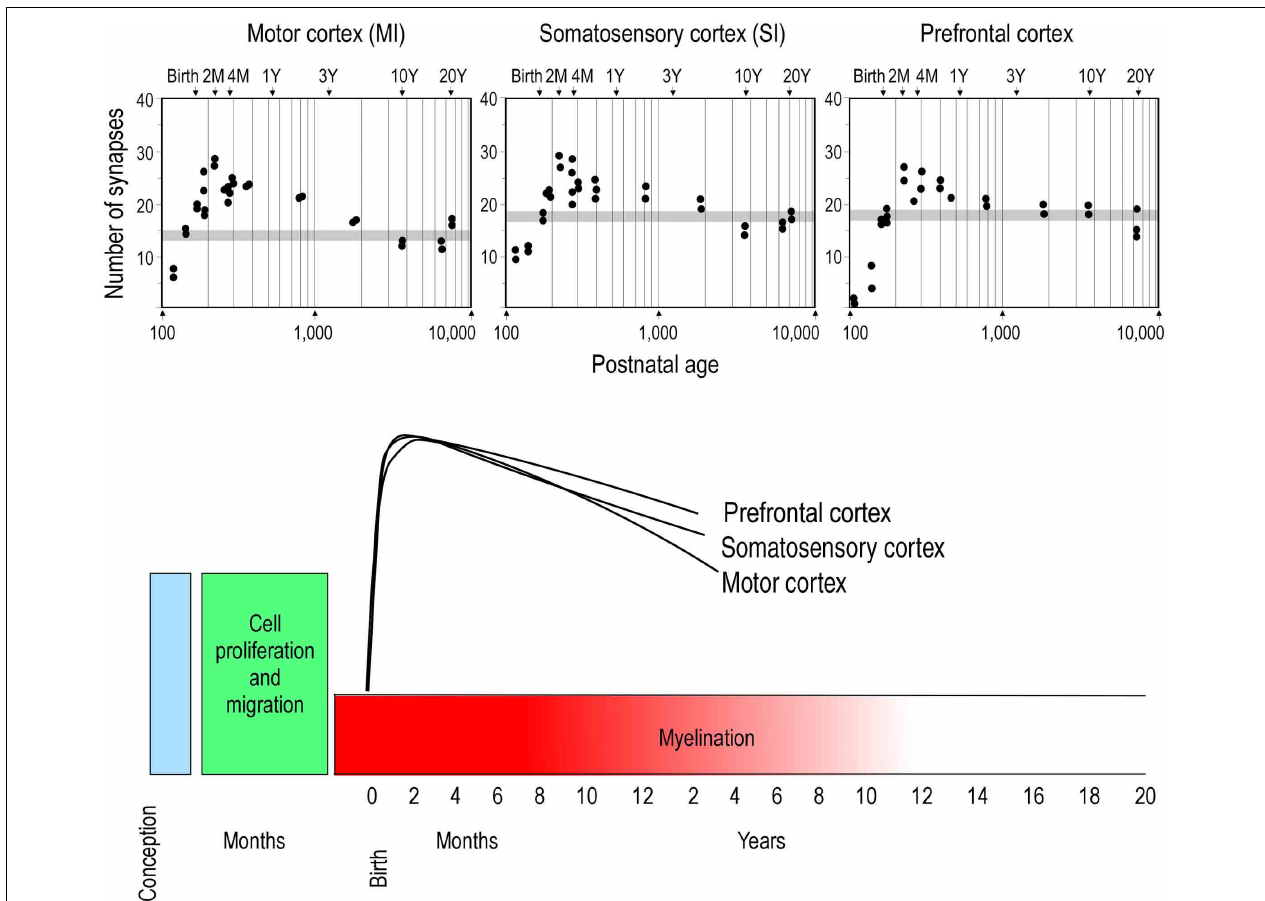
density observed in the adult in each cortical area is represented by gray stipple. Note that in all cortical areas the maximum synapse density is recorded at approximately 2 months of age. Modified from Rakic et al.